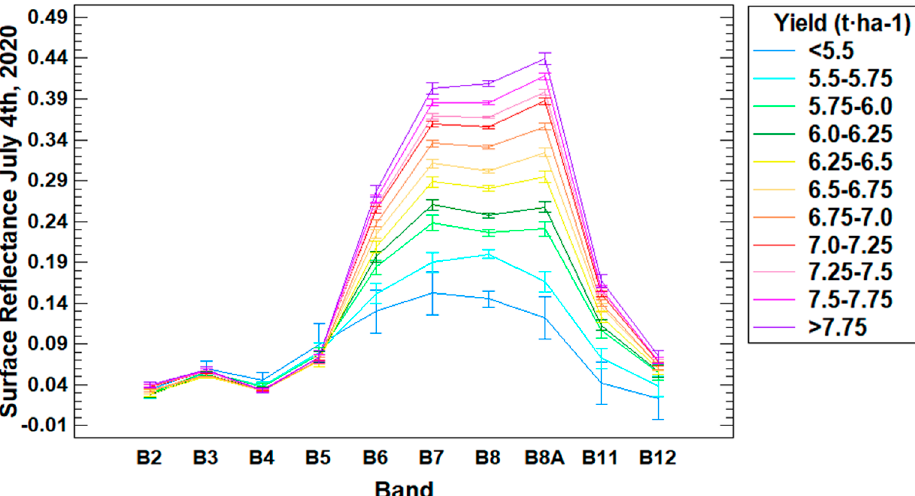
Figure 3. Surface reflectance average values for each Sentinel-2 band grouping all pixels of the JSendra training data within the yield range specified in the legend (the vertical bars indicate the LSD interval (p < 0.05) for the separation of means).